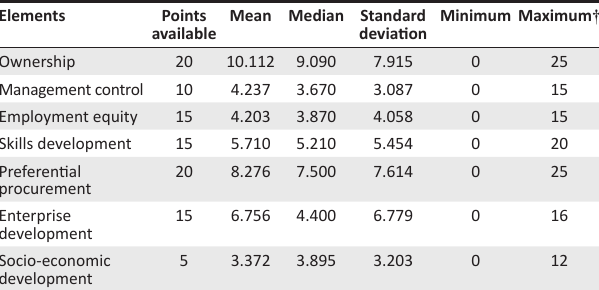
TABLE 6: Descriptive statistics for the Broad-Based Black Economic Empowerment elements.